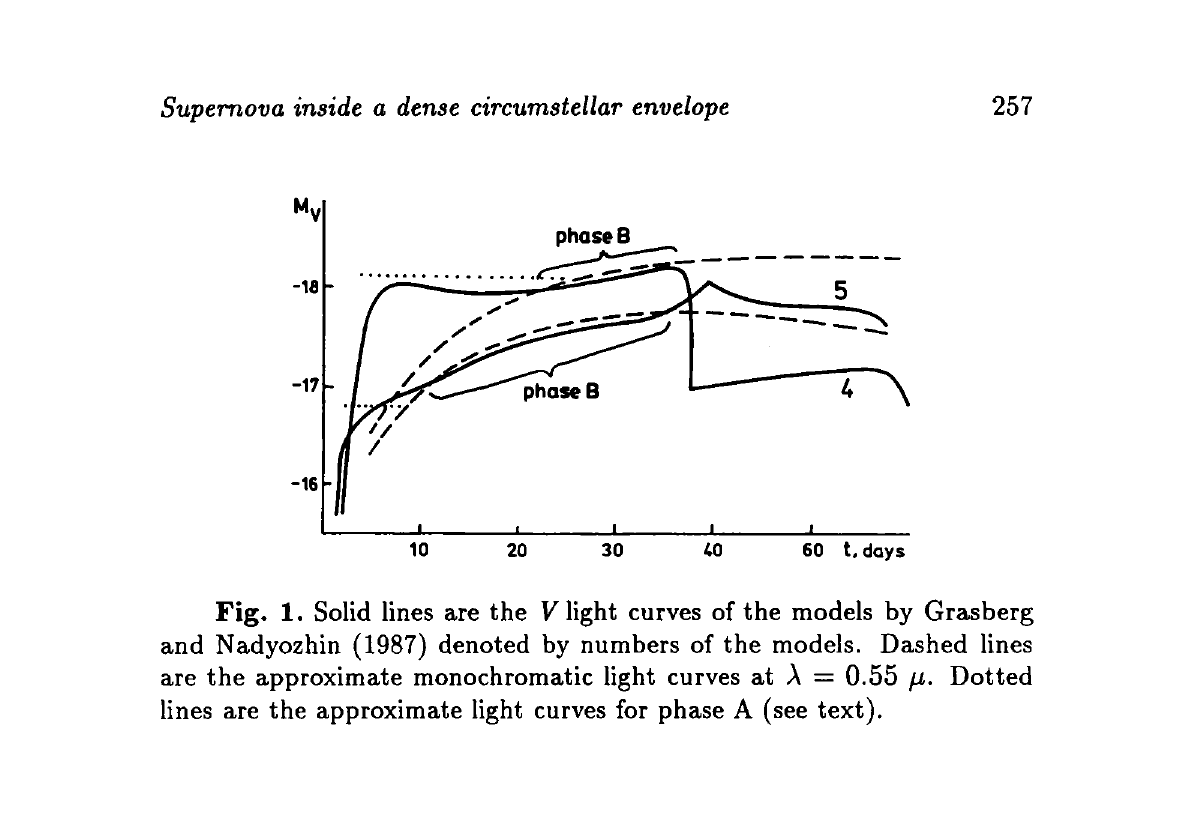
Fig. 1. Solid lines are the flight curves of the models by Grasberg and Nadyozhin (1987) denoted by numbers of the models. Dashed lines are the approximate monochromatic light curves at A = 0.55 fi. Dotted lines are the approximate light curves for phase A (see text).